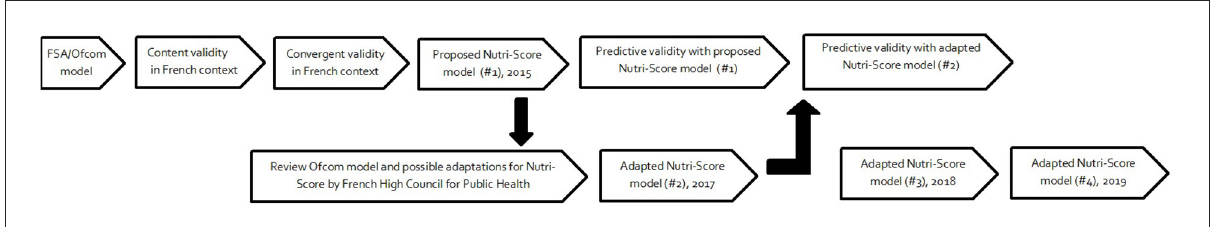
FIGURE2 The development and validation process for the Nutri-Score model prior to and during implementation in